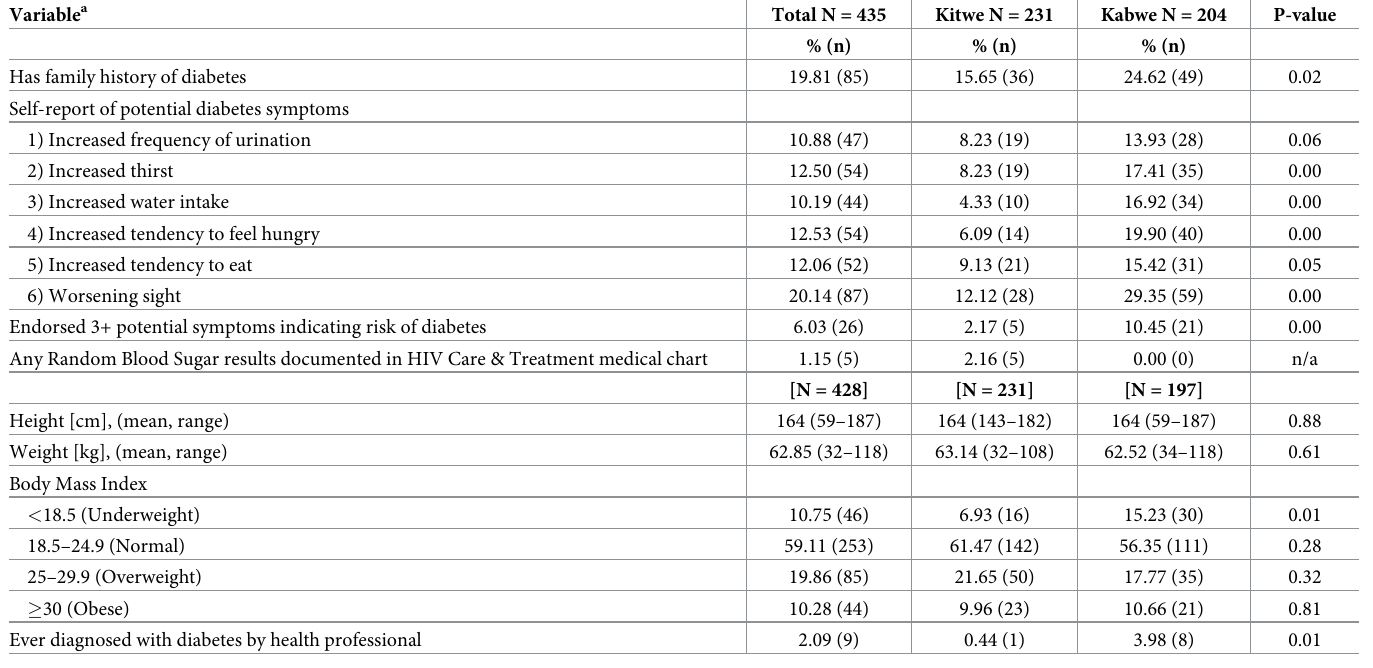
Table 2. Participant characteristics, symptoms, and risk factors related to diabetes, by